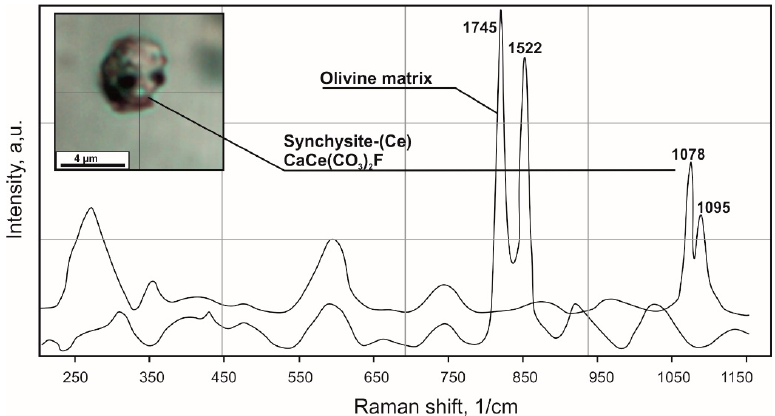
Figure 10. Raman spectroscopy analyses of the crystalline daughter phase of the secondary melt inclusion in the olivine macrocryst of the aillikites from the Terina complex. inclusion in the olivine macrocryst of the aillikites from the Terina complex.